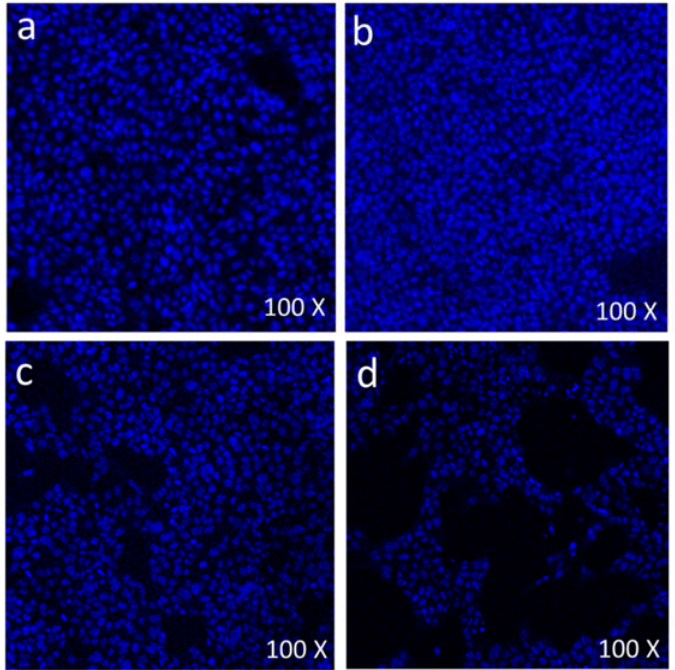
Figure 9. Scanning confocal microscopic images of MCF ‐ 7 cells stained with 4’,6 ‐ diamidino ‐ 2 ‐ phenylindole (DAPI) (blue color): The control cells (without FMSP-nanoparticles treatment) ( a phenylindole (DAPI) (blue color): The control cells (without FMSP ‐ nanoparticles treatment) ( a ), and with FMSP ‐ nanoparticles (1.25 μ g/mL) ( b ), 12.5 μ g/mL ( c ), and 50 μ g/mL ( d ).